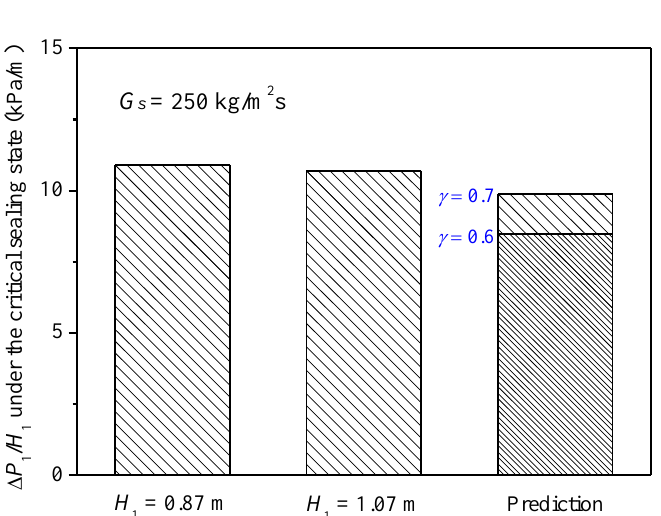
Figure 6. Comparison of predicted and experimental upper pressure gradients under the critical sealing state.